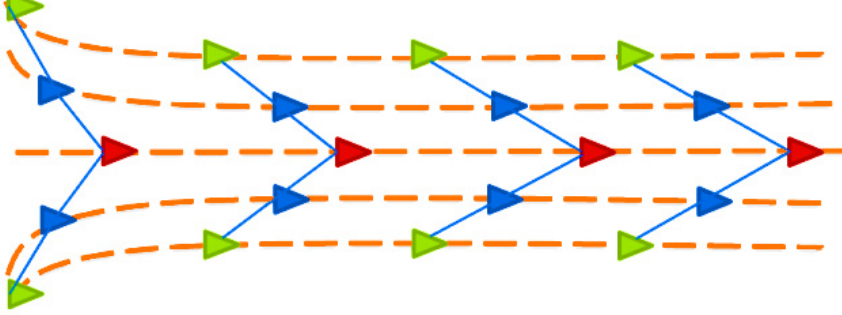
Figure 1. Leader-follower formation with triangle pattern in two dimensions.